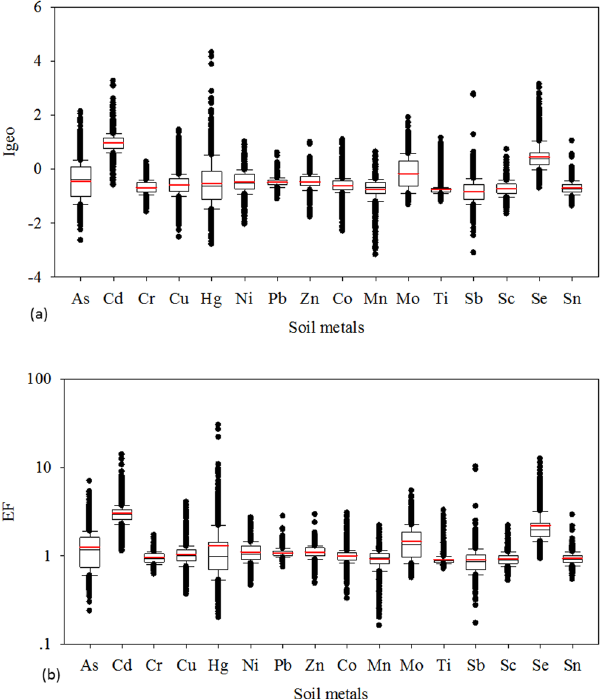
Figure 2. Pollution level of eight priority HMs and other trace elemen ts in the study area (Boxplots of Igeo ( a ) and EF ( b )) (the black horizontal line represents the median, and the red horizontal line presents the mean. The box represents the 25 th –75 th percentiles, and the whiskers represent the 10 th –90 th percentiles). (For interpretation of the references to color in this figure legend, the reader is referred to the web version of this